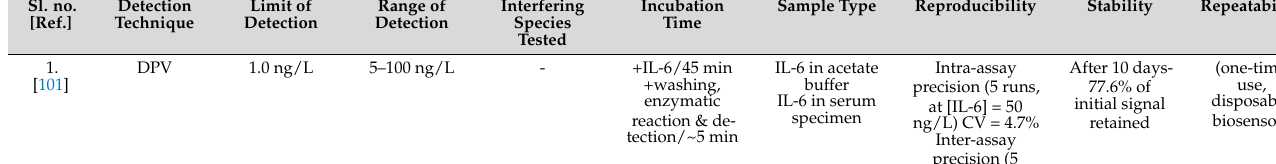
Table 14. Flow-injection/microfluidic immunosensors: Specifications and performance characteristics. Sl. no.